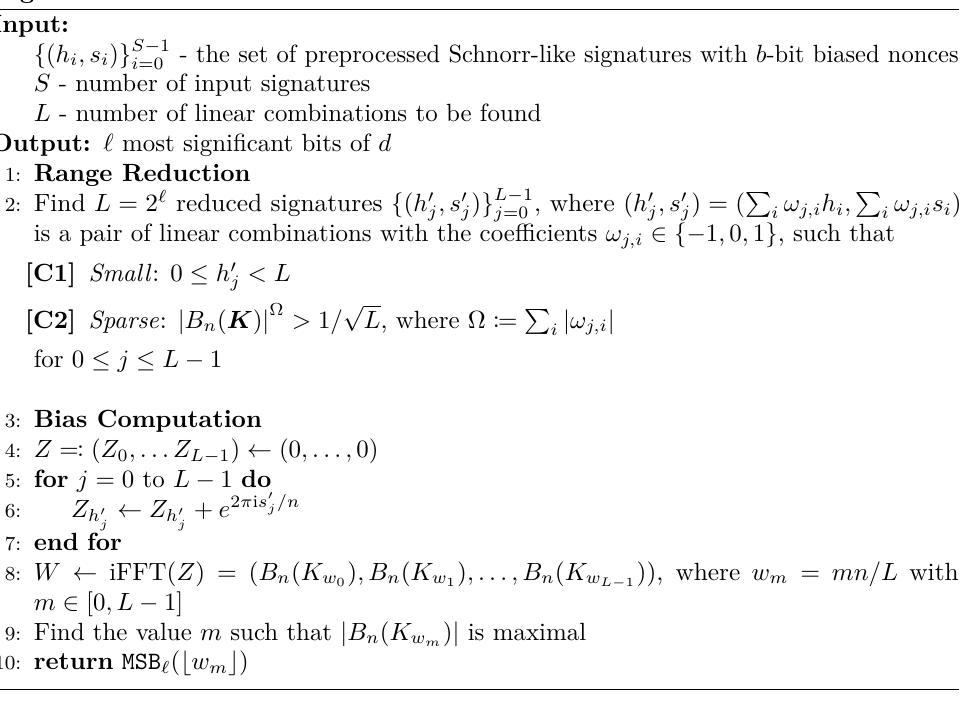
Algorithm 2 Bleichenbacher’s nonce attack